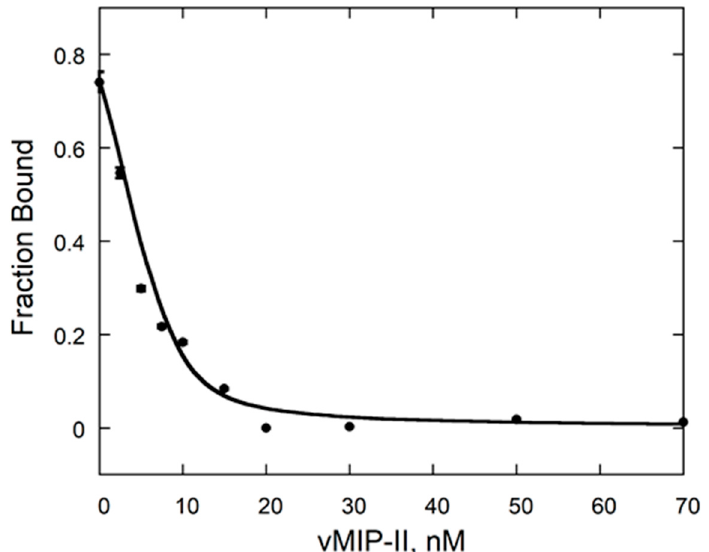
Figure 2. Competition fluorescence anisotropy of the vCCI:vMIP-II interaction. vMIP-II was added to a complex of vCCI with fluorescently labeled eotaxin-1 (CCL11) as in [11]. Error bars are shown, but are sometimes within the size of the data point.